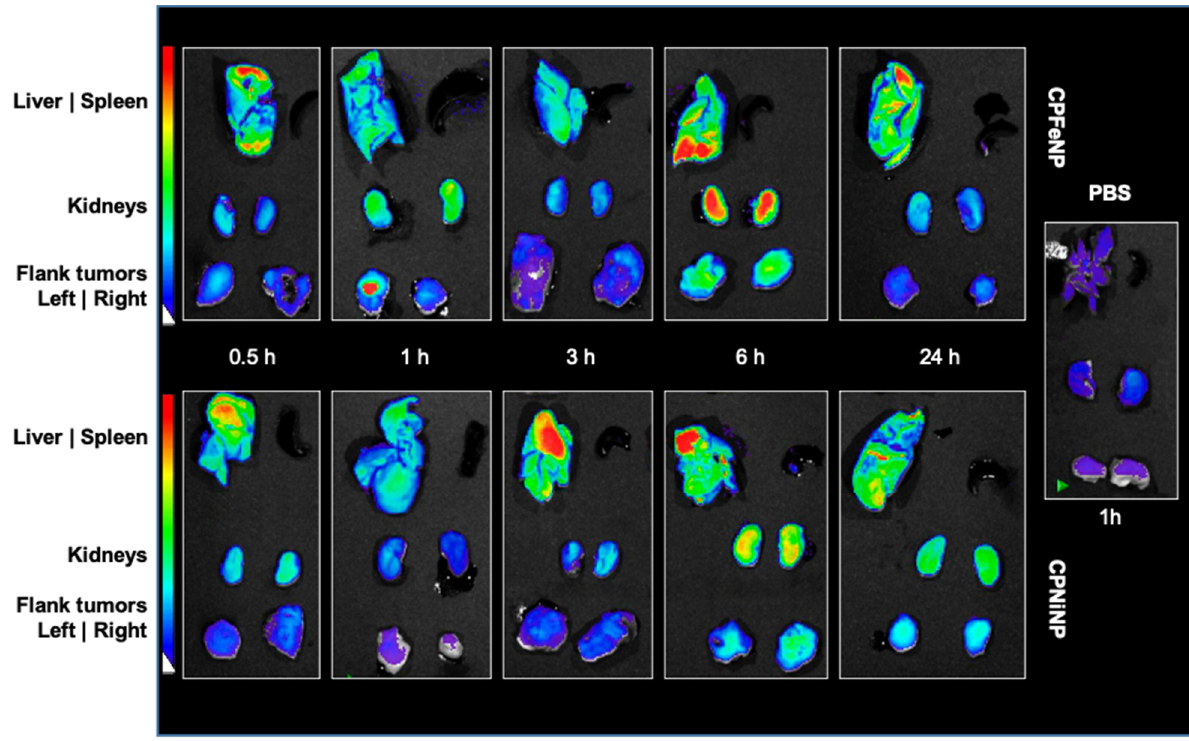
Figure 9. Fluorescence images of organs from mice euthanized at different times after IONP-doped CPN administration. Fluorescence images of liver, spleen, kidneys and flank tumors at different time points (20.5, 1, 3, 6 and 24 h) after i.v. injection of CPFeNP (upper panels) and CPNiNP (lower panels). Control: PBS (1 h) image corresponds to organs from a mouse sacrificed 1h after the injection of PBS.